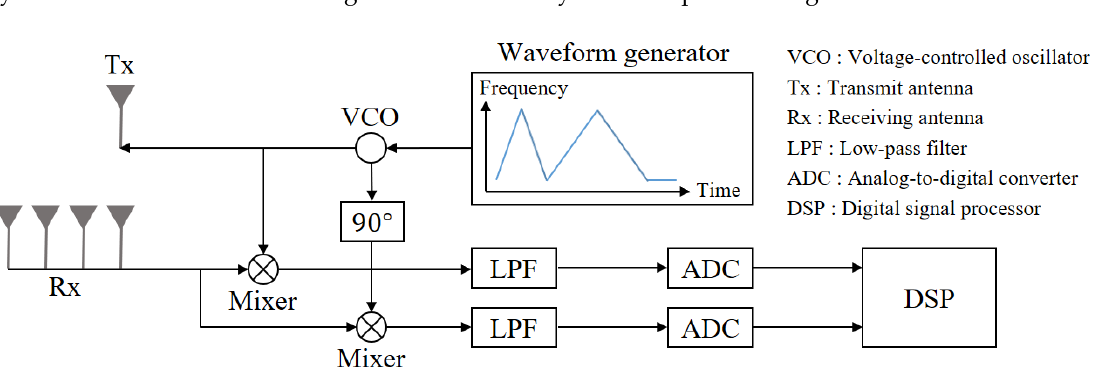
Figure 4. Schematic block diagram for radar signal